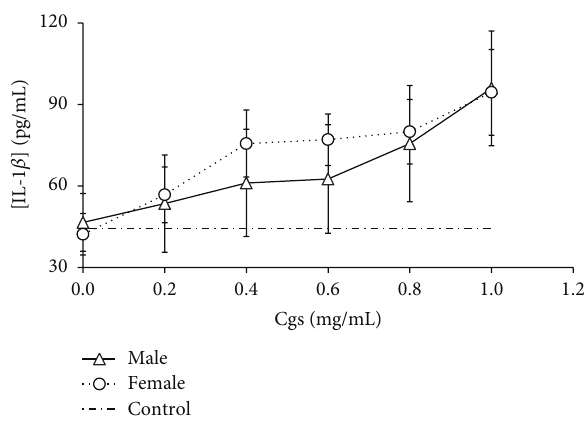
Figure 3: Increasein TNF- 𝛼 concentration (pg/mL)in culturemed- ium after the 24-hour incubation of PBMCs from male and female healthy subjects with Cgs isolated from the blood of male and female SCZ patients, respectively.